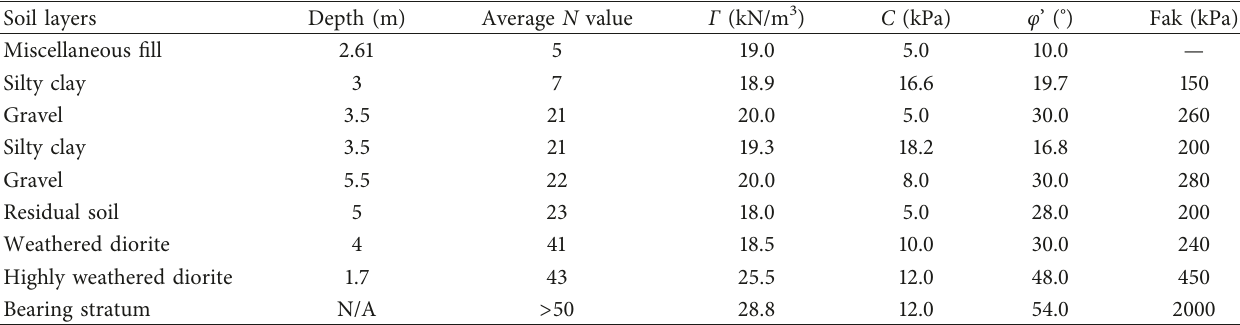
Table 1: Generalized soil